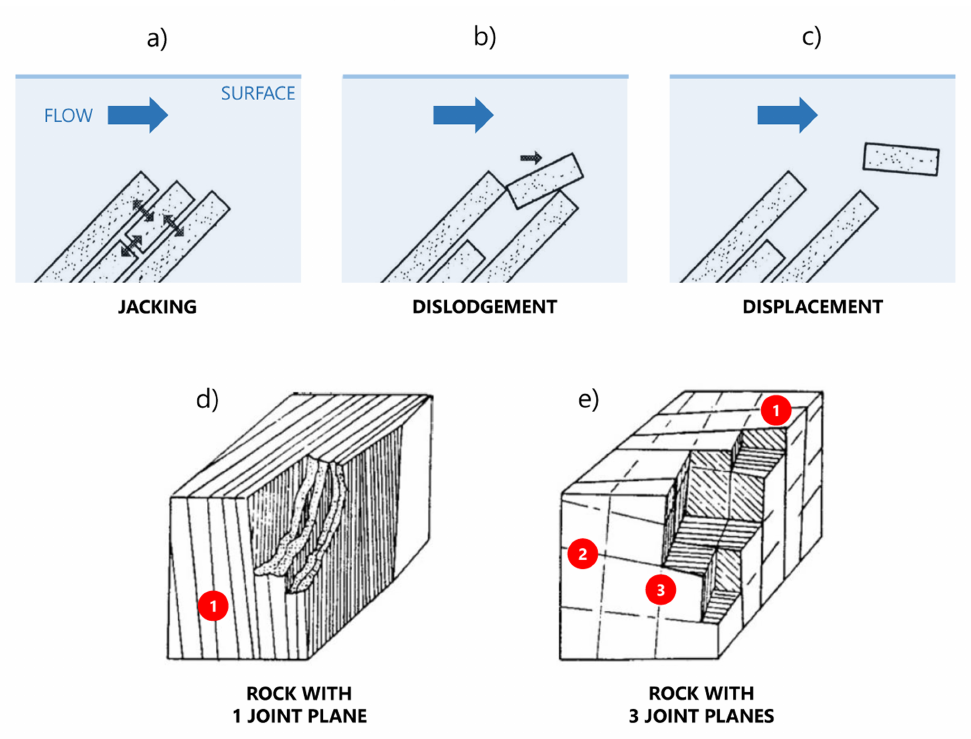
Figure 5. Consecutive steps of rock scour for a turbulent flow: ( a ) jacking, ( b ) dislodgement and ( c ) displacement. Schematic presentation of joint sets for a rock specimen, ( d ) a rock with 1 joint plane and ( e ) 3 joint planes, pointed in red circles. Figures adapted from